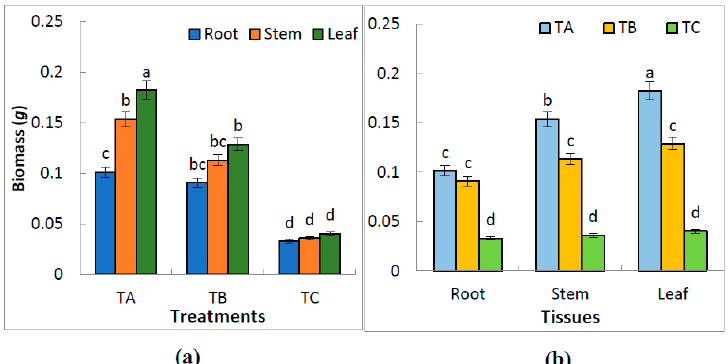
Figure 2. Effect of three water treatments (TA, well-watered (85% PC); TB, moderate water stress (65% PC); and TC, severe water stress (45% PC)) on the root, stem and leaf biomass of lucerne seedlings ( a ), and the comparison of the effects of the three water treatments in the tissues ( b ). The bars are ± one standard error of the mean ( n = 3). Means with different lower-case letters are significantly different at P = 0.05 according to Tukey’s multiple range test.